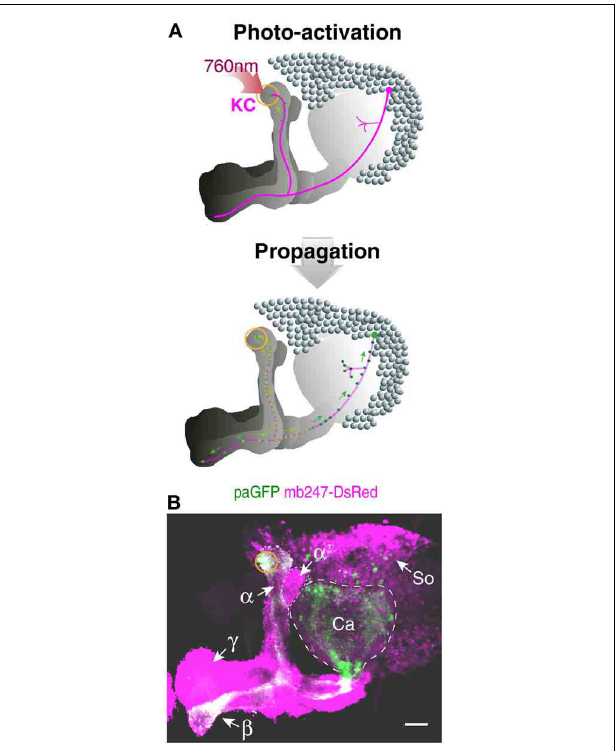
FIGURE 4 | Tracing Kenyon cells using photoactivatable GFP. (A) Schematic depiction of photoactivated GFP (paGFP) signal (green) in defined populations of Kenyon cells in a frontal projection view. Mushroom body-localized paGFP is activated using a two-photon microscope at 760nm in a region at the most posterior tip of the vertical α -lobe (upper panel). The photactivated paGFP molecules diffuse over time along the neurites and toward the cell bodies of the respective Kenyon cells (lower panel). (B) Fluorescence of paGFP in α -lobe neurons. The region of the paGFP activation is indicated by an orange circle. α , α -lobe; α (cid:3) , α (cid:3) -lobe; β , β -lobe; γ , γ -lobe; Ca, calyx; So, somata; KC, Kenyon cell. Scale bars = 40 μ